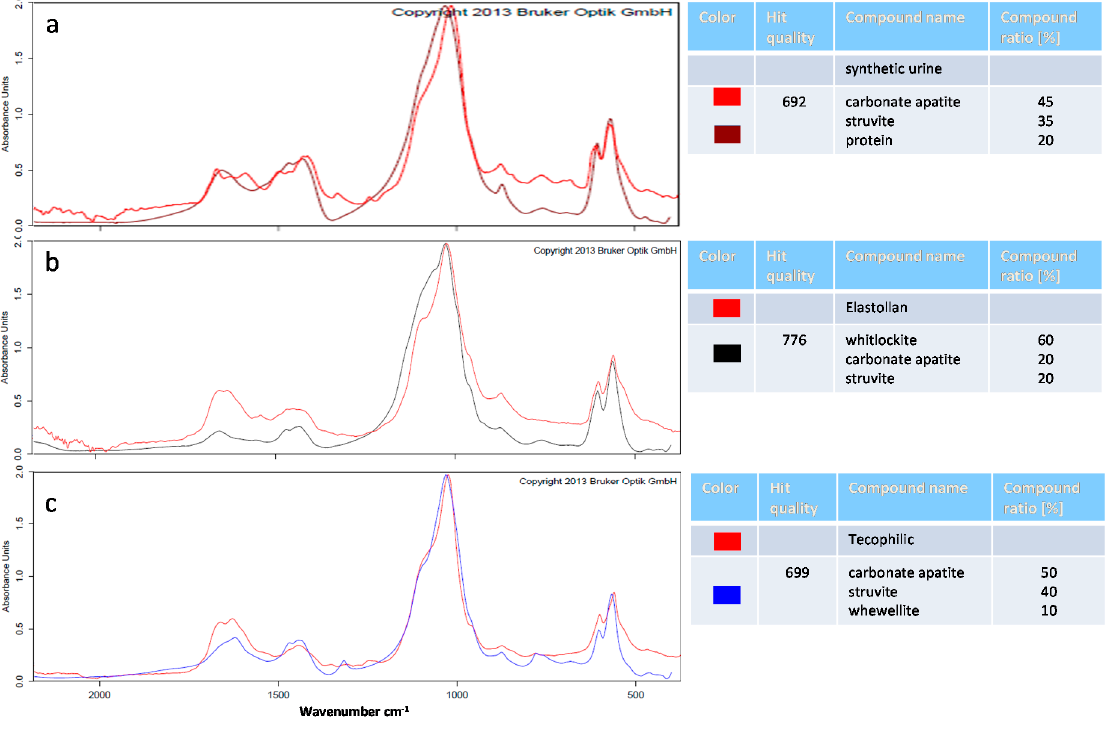
Figure 7. FTIR analysis of encrustations formed in the in vitro-encrustation system. Measured absorption spectra (red) of mineral deposits of the synthetic urine without polymer ( a ) or the precipitations on the polymer samples (Elastollan: b , Tecophilic: c ). Absorption spectra of the OPUS ™ reference library with the best match are shown in purple, black, and blue, respectively. The amount of calcium phosphate (carbonate apatite and whitlockite) precipitates is higher on Elastollan. In contrast, on Tecophilic, the amount of magnesium phosphates (struvite) is elevated compared to complete urine precipitates. (ALPHA FTIR spectrometer, OPUS TM library, Bruker).